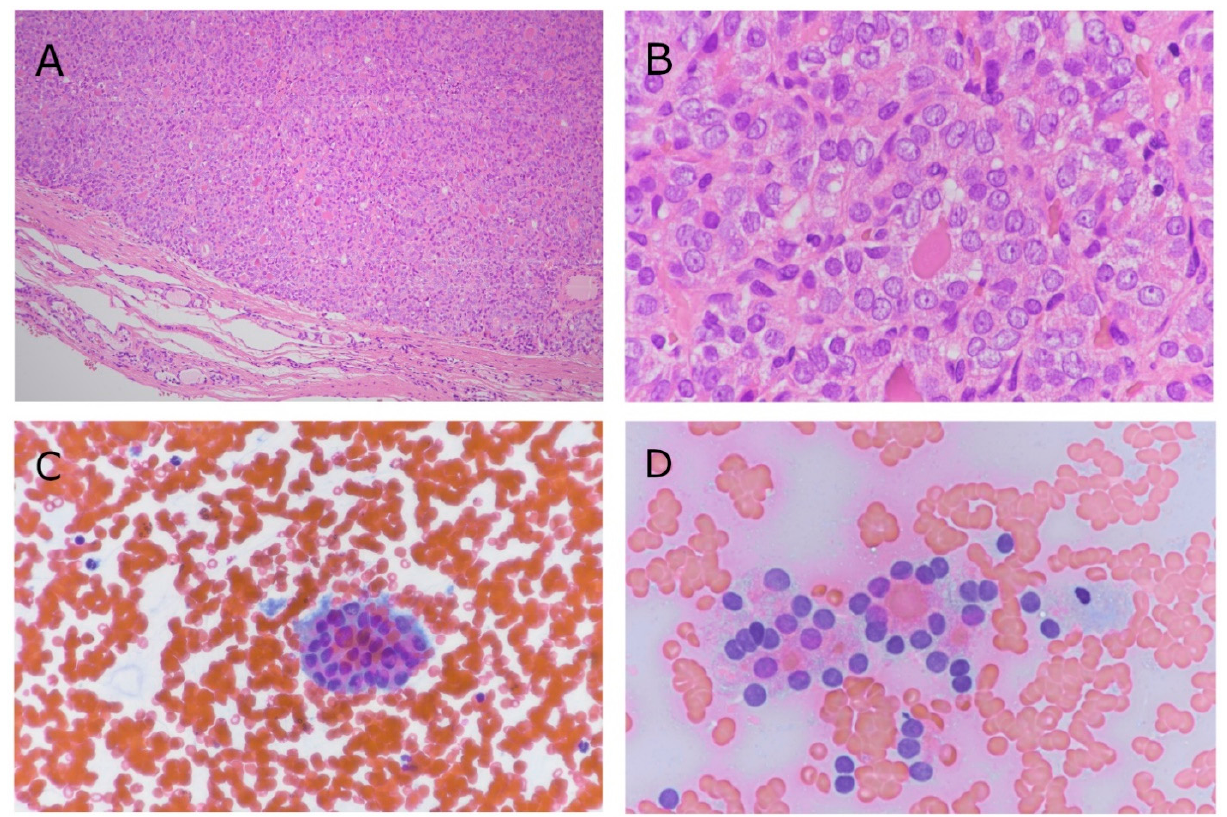
Figure 1. Histopathological and cytological images of NIFTPs. ( A ) Low magnification (original magnification: 10 × ). The tumour appears completely encapsulated without signs of vascular and/or capsular invasion. ( B ) Higher magnification (60 × ) of neoplastic cells. Papillary-like nuclear features are evident at this magnification. ( C ) Cytological smear of the same case diagnosed as indeterminate nodule (60 × ). The picture shows a microfollicular structure with mild/moderate nuclear atypia. ( D ) Another NIFTP case with indeterminate cytology. Two microfollicles are reported at high magnification (60 × ). Table 2. Characteristics of NIFTP with and without collateral malignant